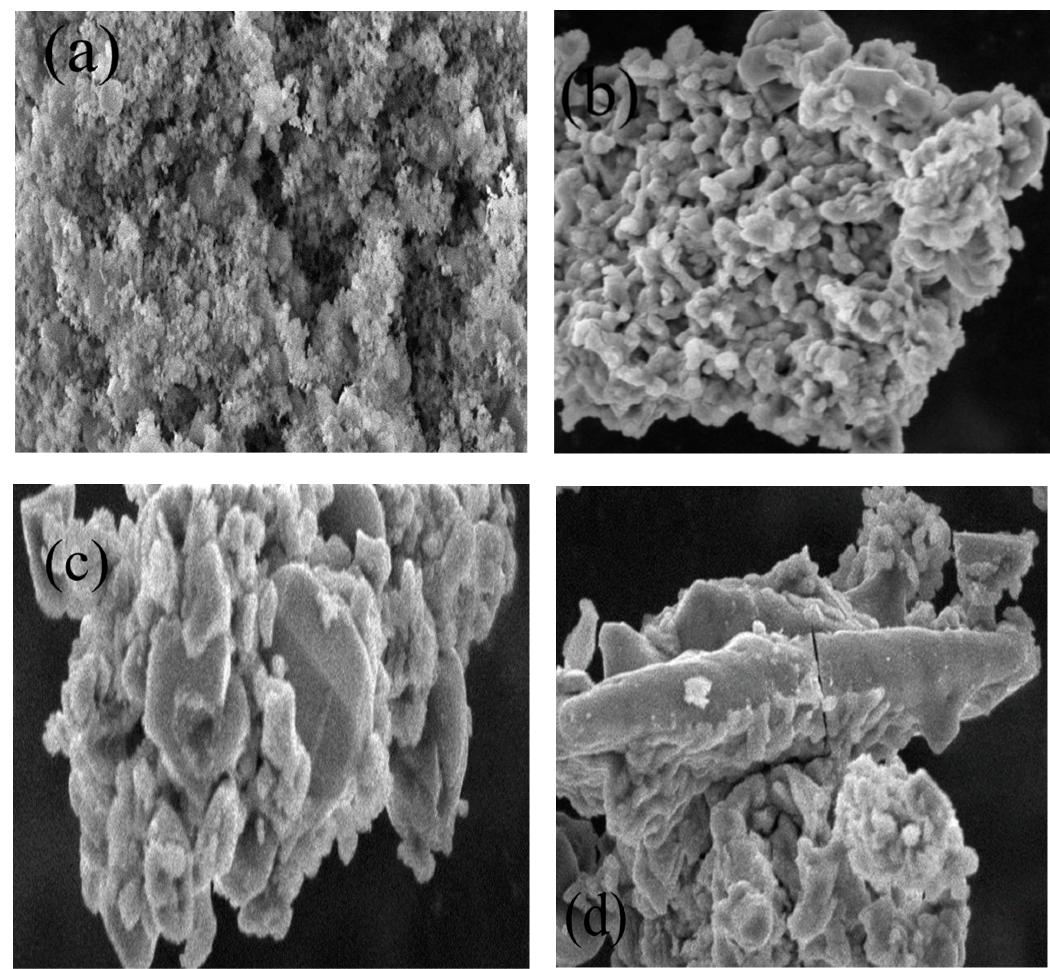
Figure 2. SEM images of ( a ) TiO 2 , ( b ) TiO 2 -0.25Li, ( c ) TiO 2 -0.5Li, and ( d ) TiO 2 -0.75Li.